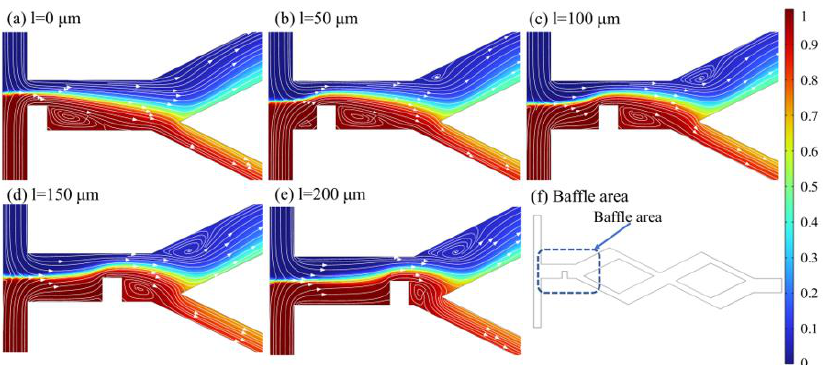
Figure 17. Concentration distribution and velocity streamline in the baffle area at Re = 60. ( a ) l = 0 µ m; ( b ) l = 50 µ m; ( c ) l = 100 µ m; ( d ) l = 150 µ m; ( e ) l = 200 µ m; ( f ) Baffle area